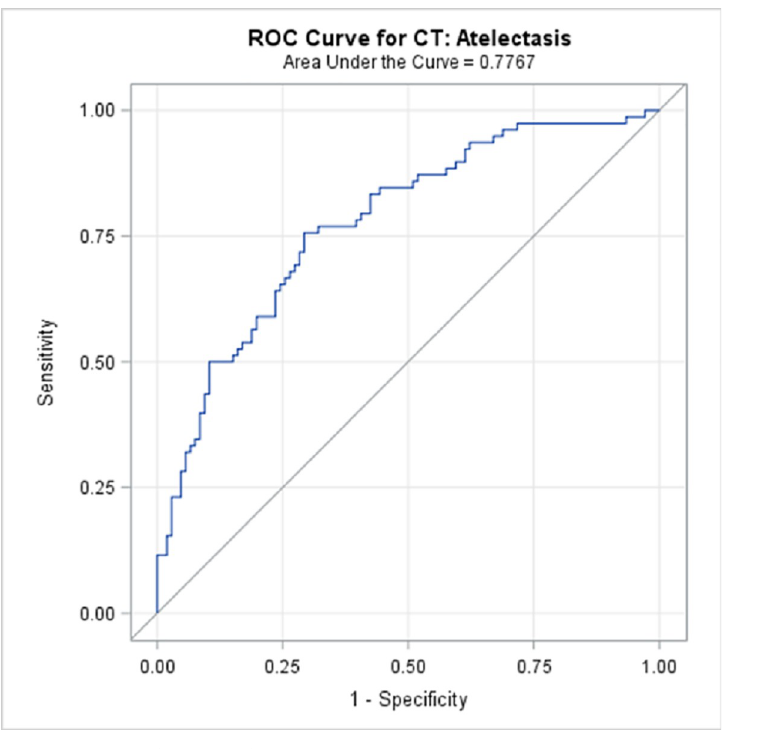
Fig 8. ROC Curve for CT: Atelectasis.